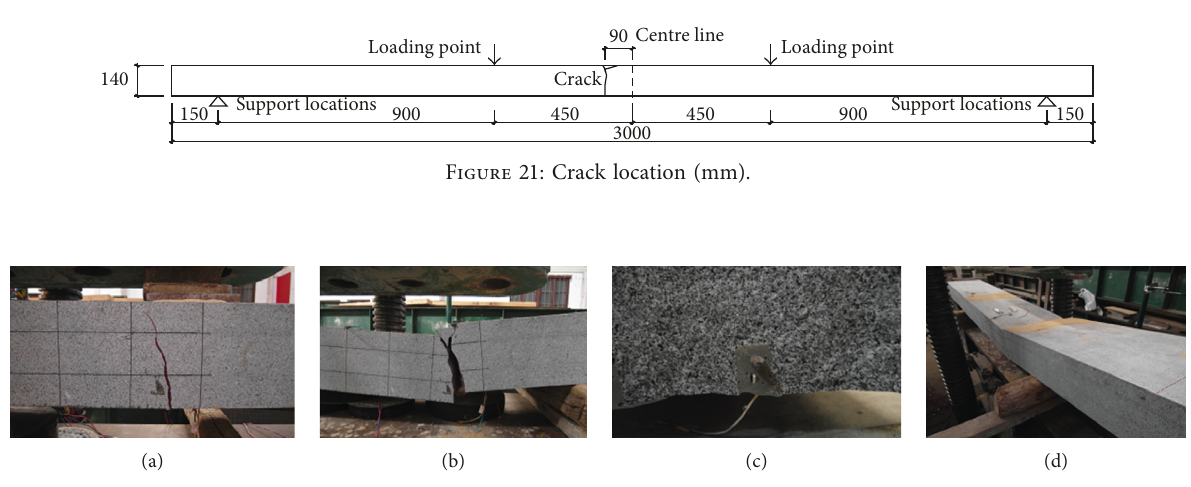
Figure 22: Failure mode of GB-4: (a) initial vertical crack; (b) fully cracking; (c) steel bars crushed; (d) final failure